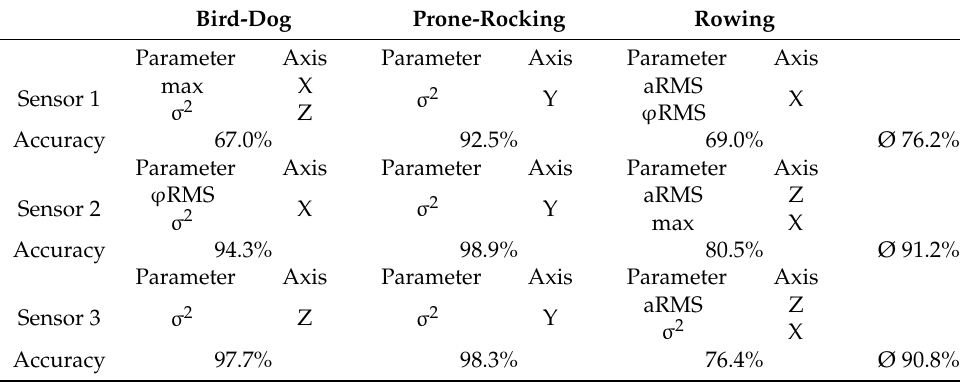
Table 3. Single sensor features and corresponding accuracies for binary decision trees.